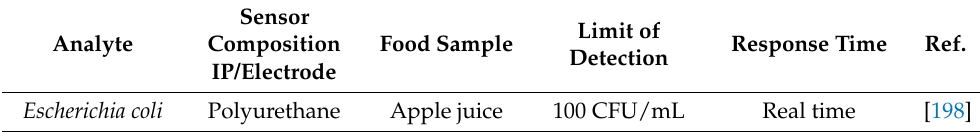
Table 9. Imprinted polymer-thermometric sensors for food